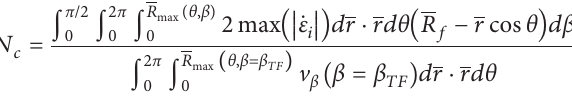
Figure 8: Layout of the derived continuous velocity field for deep tunnel collapse ( C/D � 4, c D / s downward movement; (b) tunneling in upward